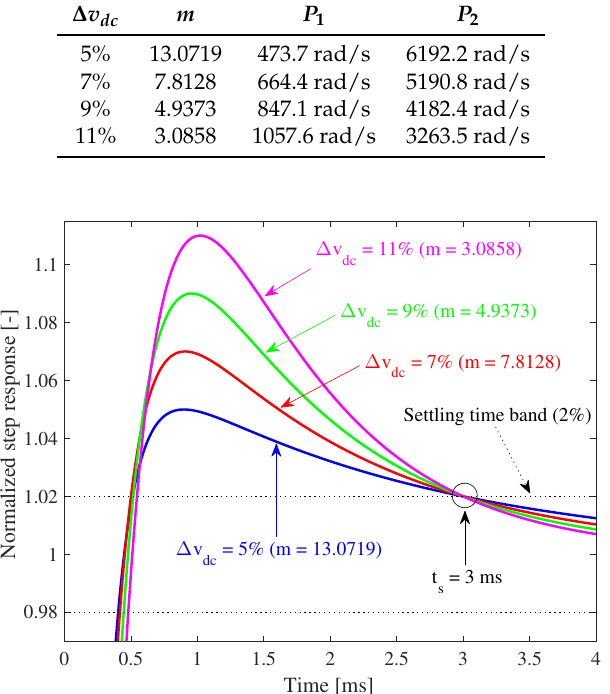
Figure 10. Simulation of G dc ( s ) with values of P 1 to ensure that t s = 3 ms for a settling time band (cid:101) =